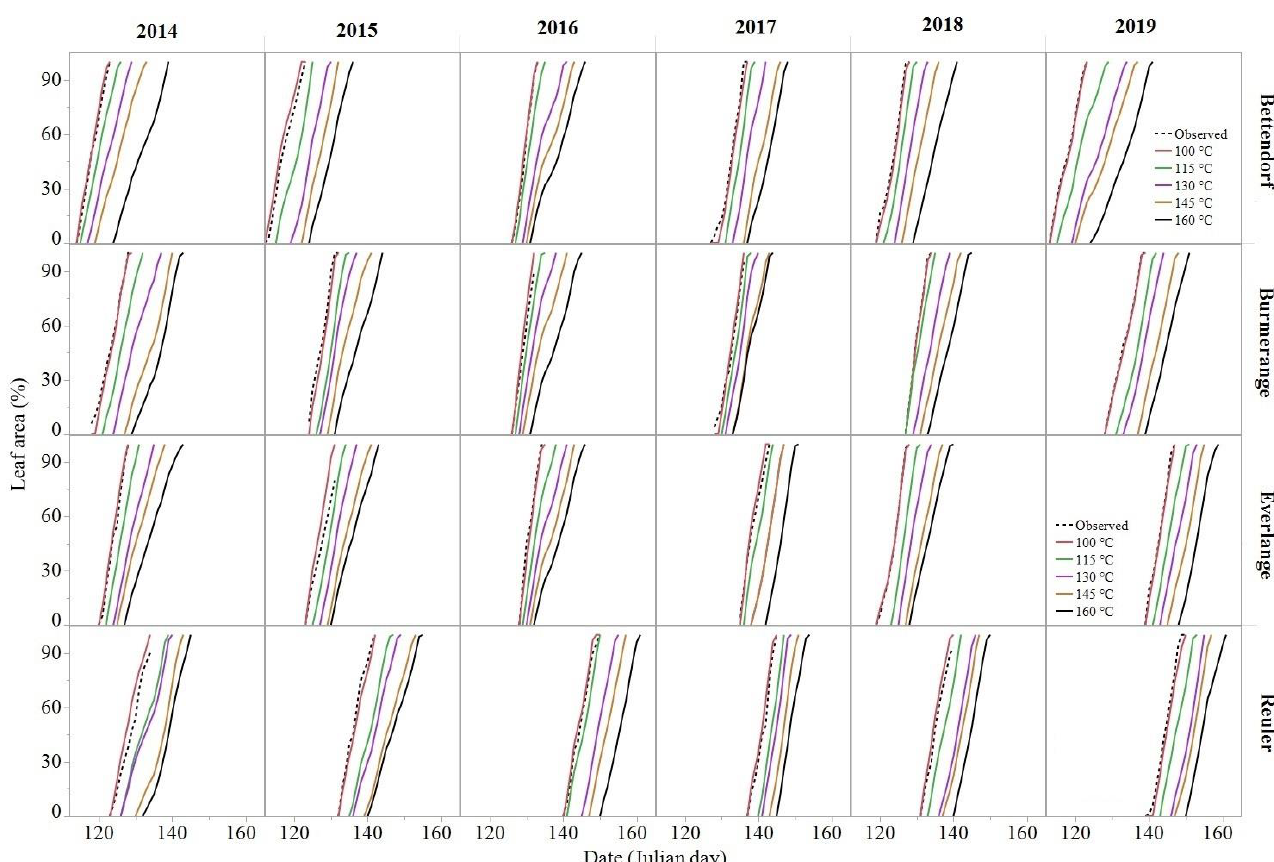
Figure 3. Observed (dashed lines) and predicted (solid lines) percentage emergence of formation of the flag leaf (F) in winter wheat during the 2014–2019 cropping seasons at the different study sites in the Grand-Duchy of Luxembourg. The percentage of emerged leaf area for each of the three leaf layers was estimated by comparison to the total area of the preceding fully emerged leaf (assumed as 100%), and by checking the ligule of the emerging leaf (a fully visible leaf ligule corresponds to a fully emerged leaf). The percentage emerged areas were estimated for each of the 40 replicate plants at each assessment. In all years only values for the cultivar Kerubino were used. Note: the curve for observed values and that for predicted values using the 100 °Cd phyllotherm appear superposed in most of the graphs.